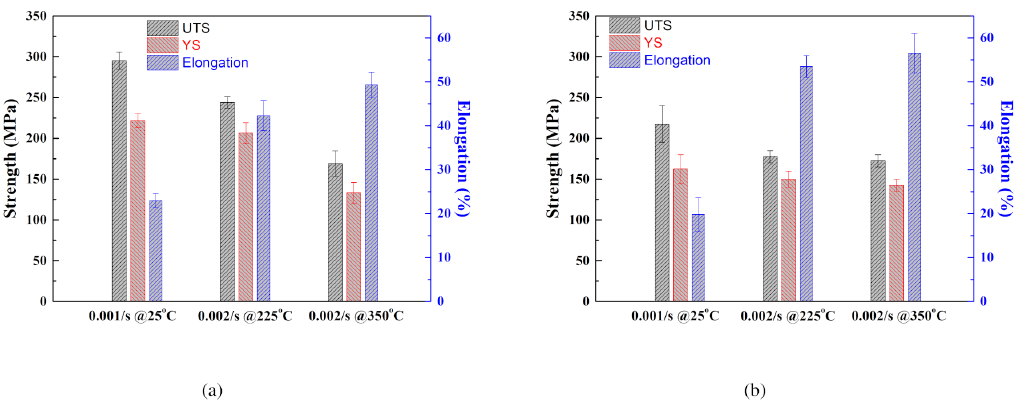
Figure 4. Mechanical properties of Mg-Al-Mn sheets. UTS: ultimate tensile strength [MPa]. YS: yield strength [MPa]. ( a ) TRC, and ( b )